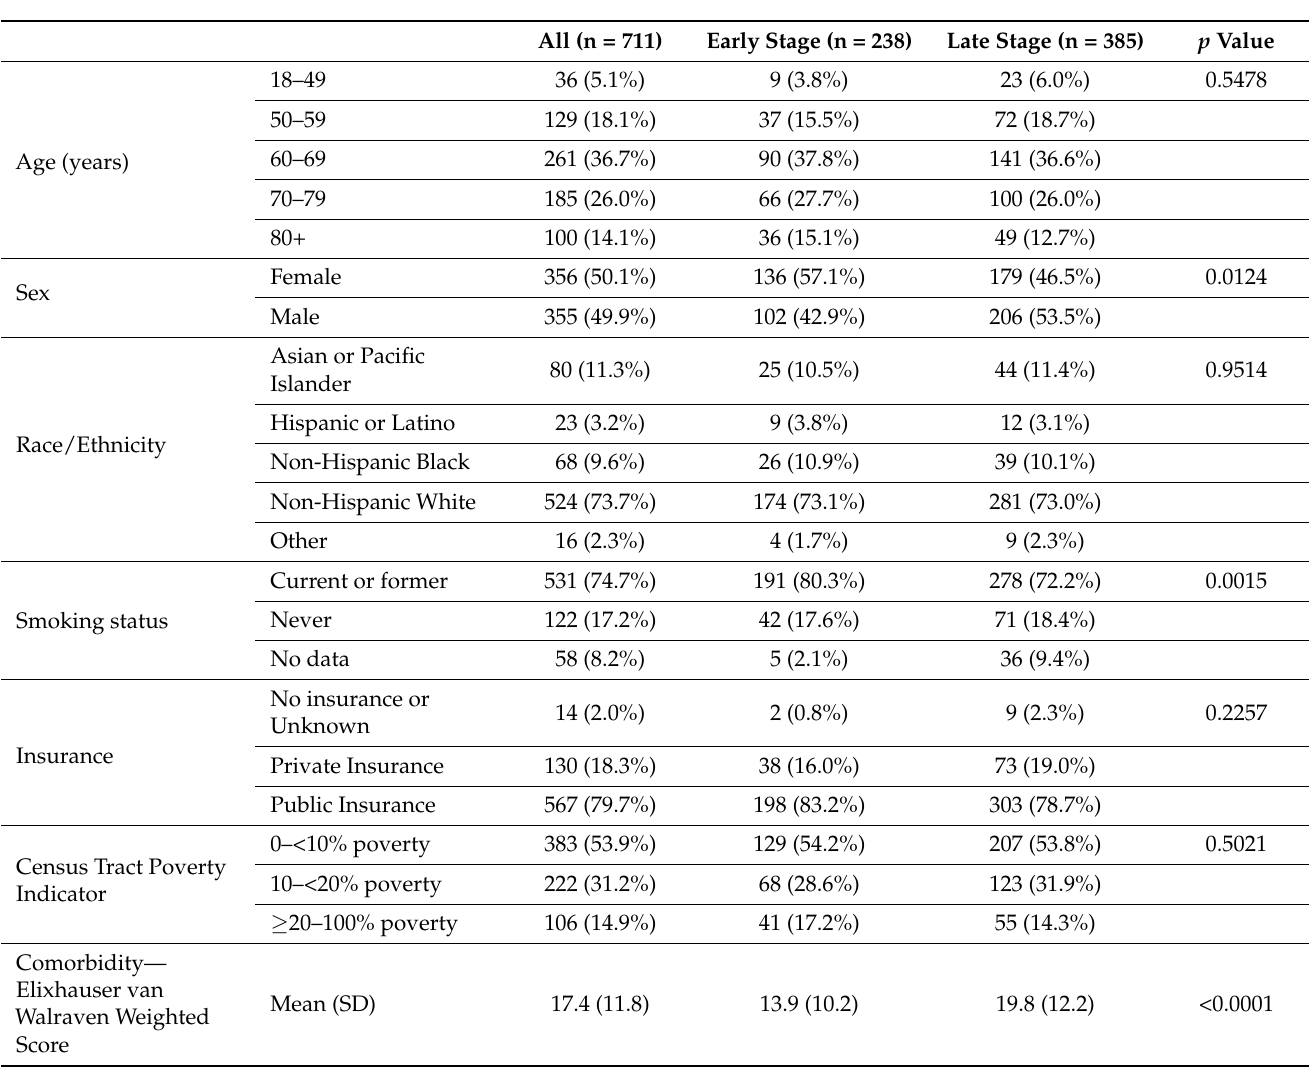
Table A3. Comparisons between characteristics of patients with lung cancer at time of diagnosis, by late vs. early stage.